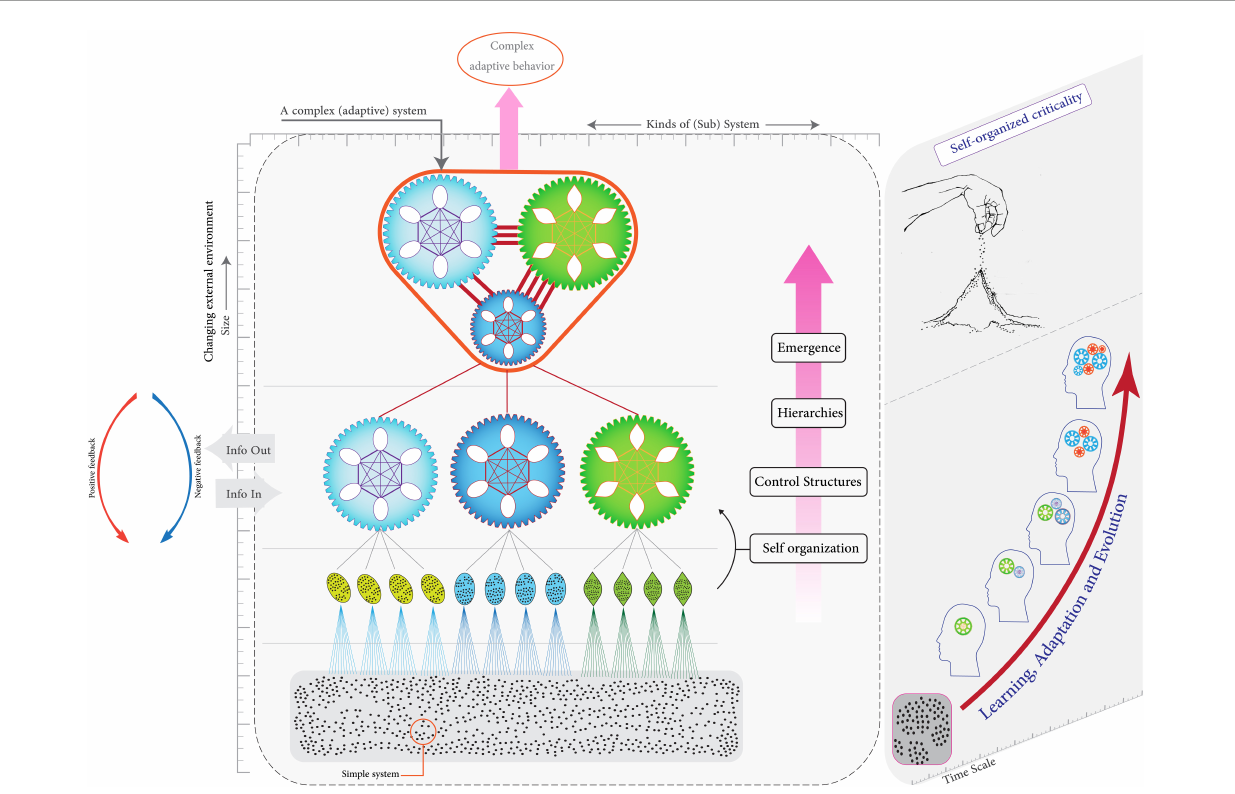
FIGURE1 Characteristics of complex adaptive systems (CAS) and how they work. A CAS is a system that consists of many adaptive agents which interact with each other and their external environment. The interaction of components leads to collective behaviors which are different/greater than the sum of the parts (emergence). CAS evolves over